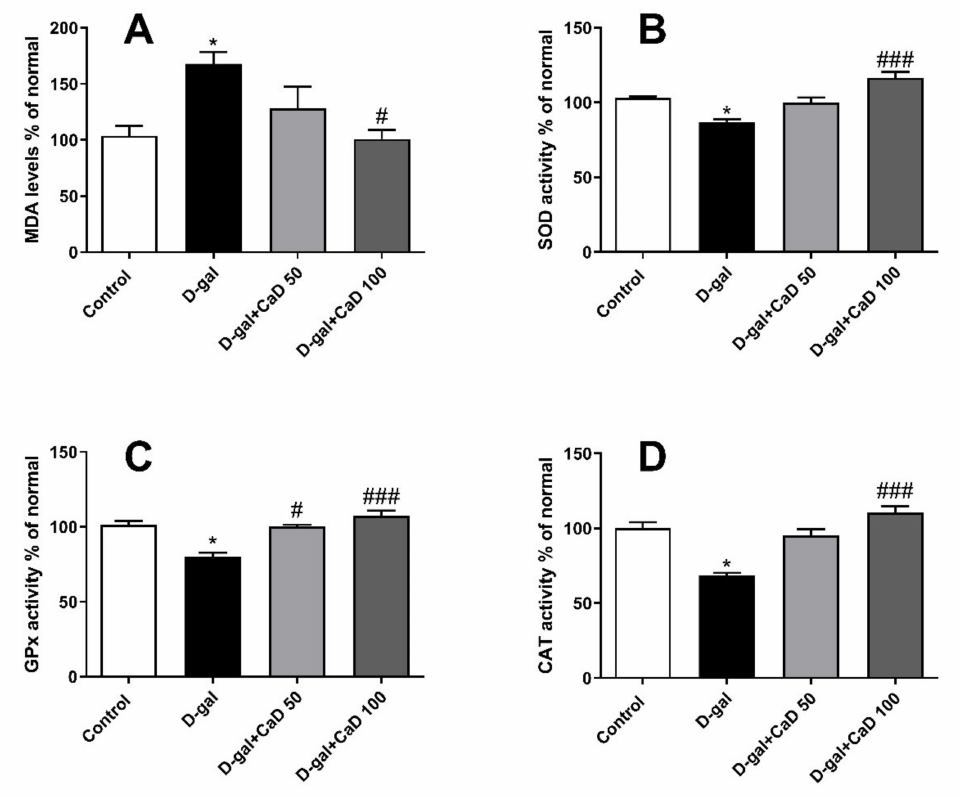
Figure 4. Effect of calcium dobesilate (CaD; 50 and 100 mg/kg, p.o.) on oxidative stress indices in D-gal treated mice. ( A ) MDA levels % of normal, ( B ) SOD activity % of normal, ( C ) GPX activity % of normal, ( D ) CAT activity % of normal. Values are mean ± SEM ( n = 7 in each group). * p < 0.05 as compared to control group; # p < 0.05 and ### p < 0.001 as compared to D-Gal treated group; MDA: malondialdehyde; SOD: superoxide dismutase; GPx: glutathione peroxidase; CAT: